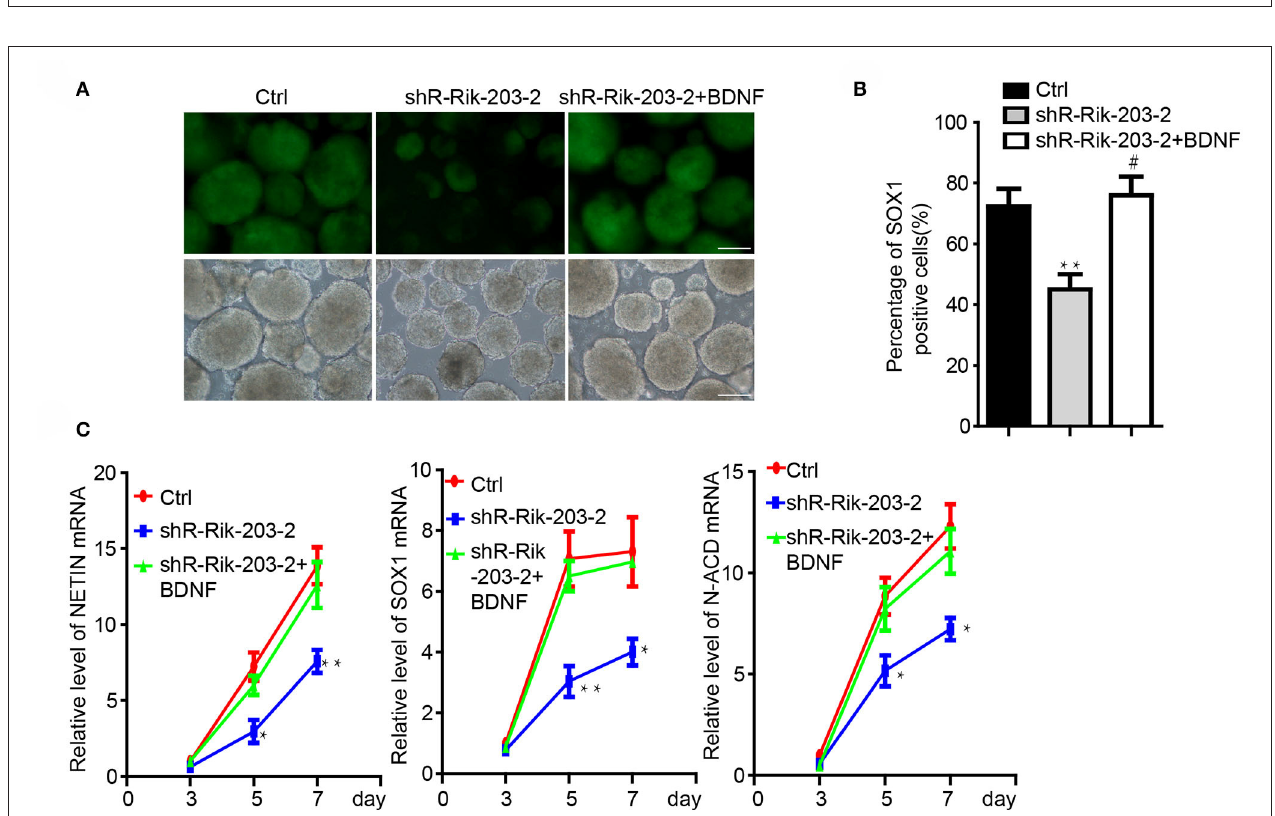
FIGURE 3 | wild-type BDNF 3 ′ UTR but not mutant UTR. (D) Overexpression of miR-466l-3p decreased the protein level of BDNF. (E) Knockdown of the BDNF inhibited the neural differentiation. (F) Flow cytometry assay confirmed the downregulation of BDNF repressed the proportion of Sox1-GFP positive cells. (G) Detection of the NSCs related genes Sox1, Nestin, N-cadherin expression by qRT-PCR. (H) Overexpression of BDNF blocked the neural differentiation caused by miR-466l-3p, which was also confirmed in (I) . (J) Detection of the expression of Sox1, Nestin, and N-cadherin in the (H) . The scale bar represents 100 µ m. * p < 0.05, ** p < 0.01; ** or ## p < 0.01.